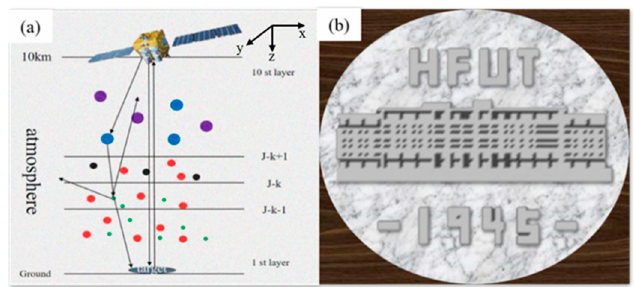
Figure 1. ( a ) The schematic of the system model; and ( b ) imaging object.